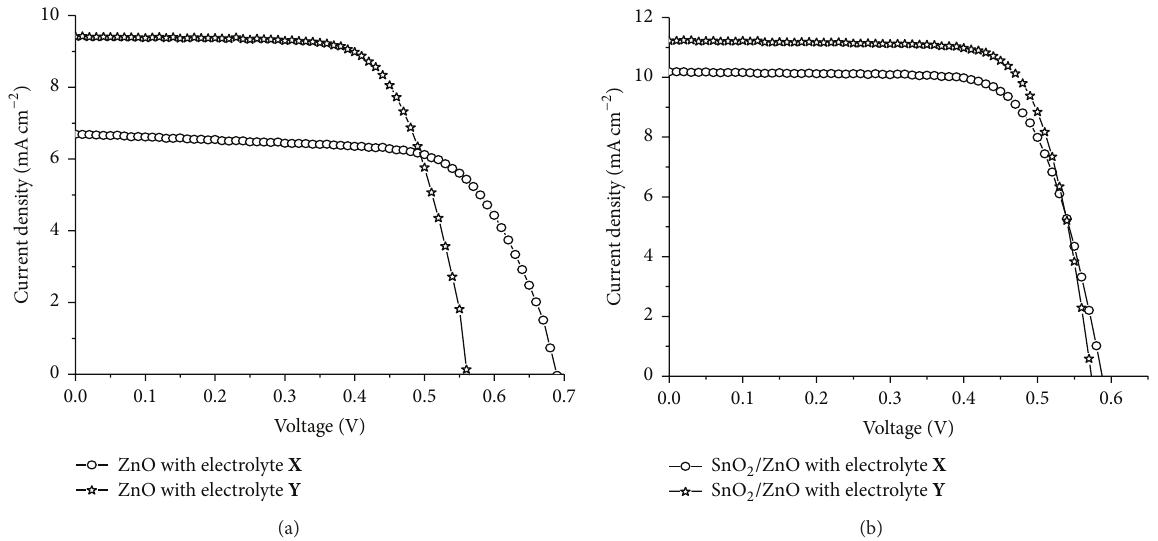
Figure 3: Variations of solar cell parameters of DSCs made using various compositions of ZnO-coated SnO 2 on with electrolyte X . Variation , (b) 𝐽 , (c) efficiency, and (d) fill factor, respectively, under 100mWcm −2 illumination. of (a) 𝑉 OC SC